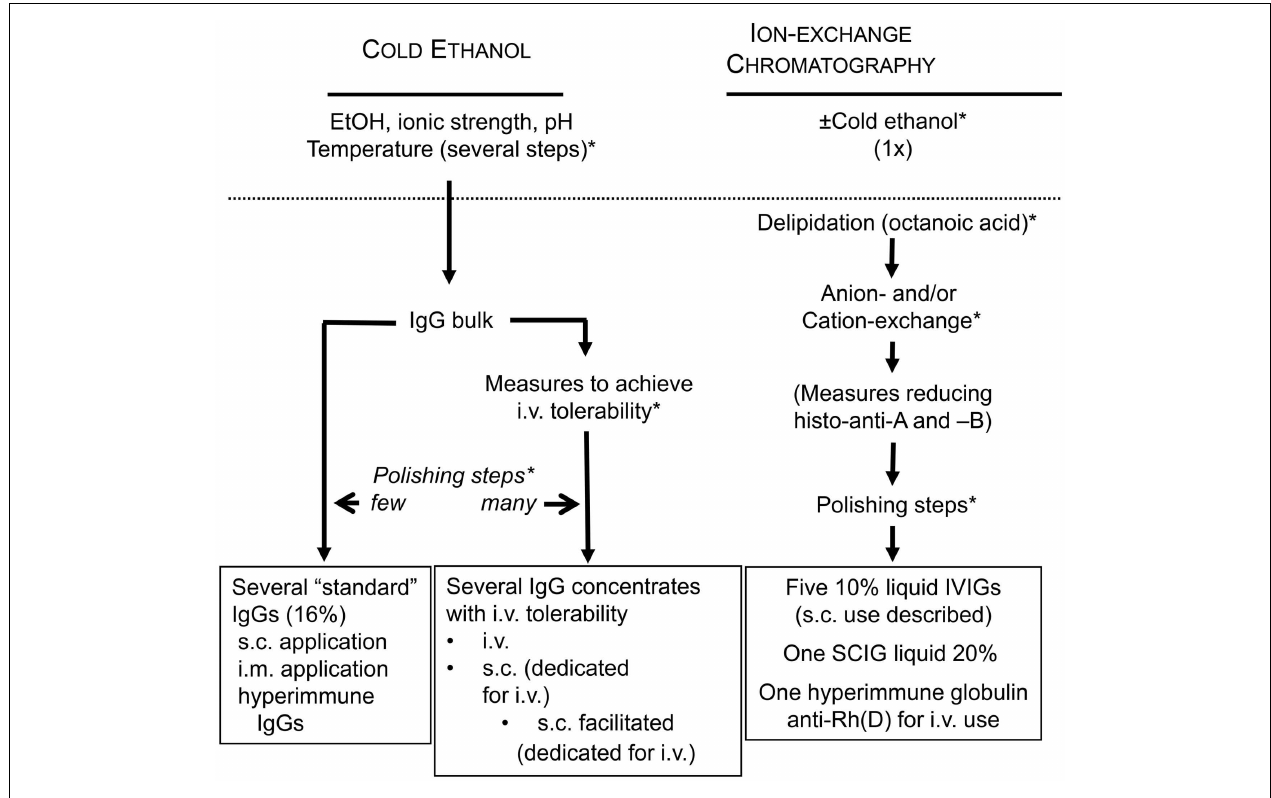
antibodies were made responsible for hemolytic AEs. Reduction of these during the manufacturing process is possible by introduction of an immunoaffinity chromatographic step in order to reduce anti-A and anti-B